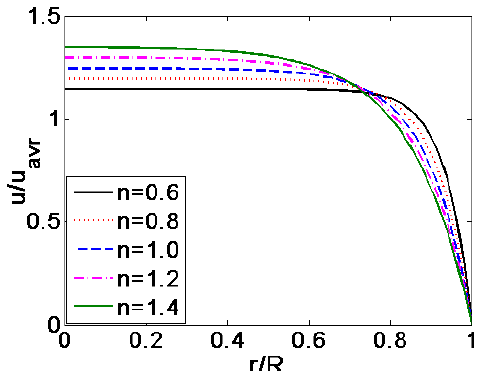
Figure 4. The comparison of the dimensionless velocity profiles generalized with the respective dimensionless average velocity for various flow behavior index n ( K = 10, ξ = − 4).